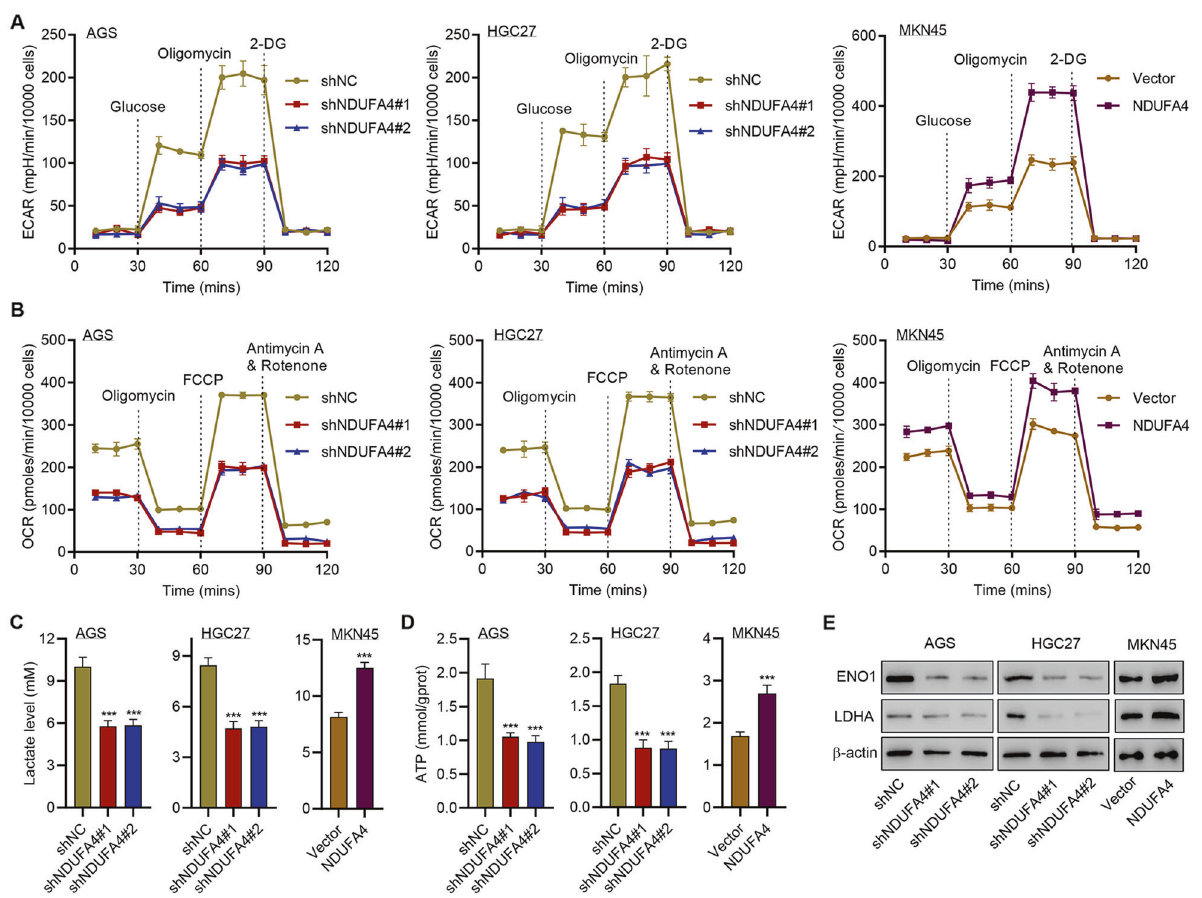
Fig. 4 NDUFA4 promotes glycolytic and oxidative metabolism in GC cells. A ECAR, ( B ) OCR, ( C ) lactate, ( D ) ATP content and ( E ) expression of ENO1 and LDHA in AGS, HGC27 and MKN45 cells with or without NDUFA4 overexpression or knockdown. *** P < 0.001 vs shNC or